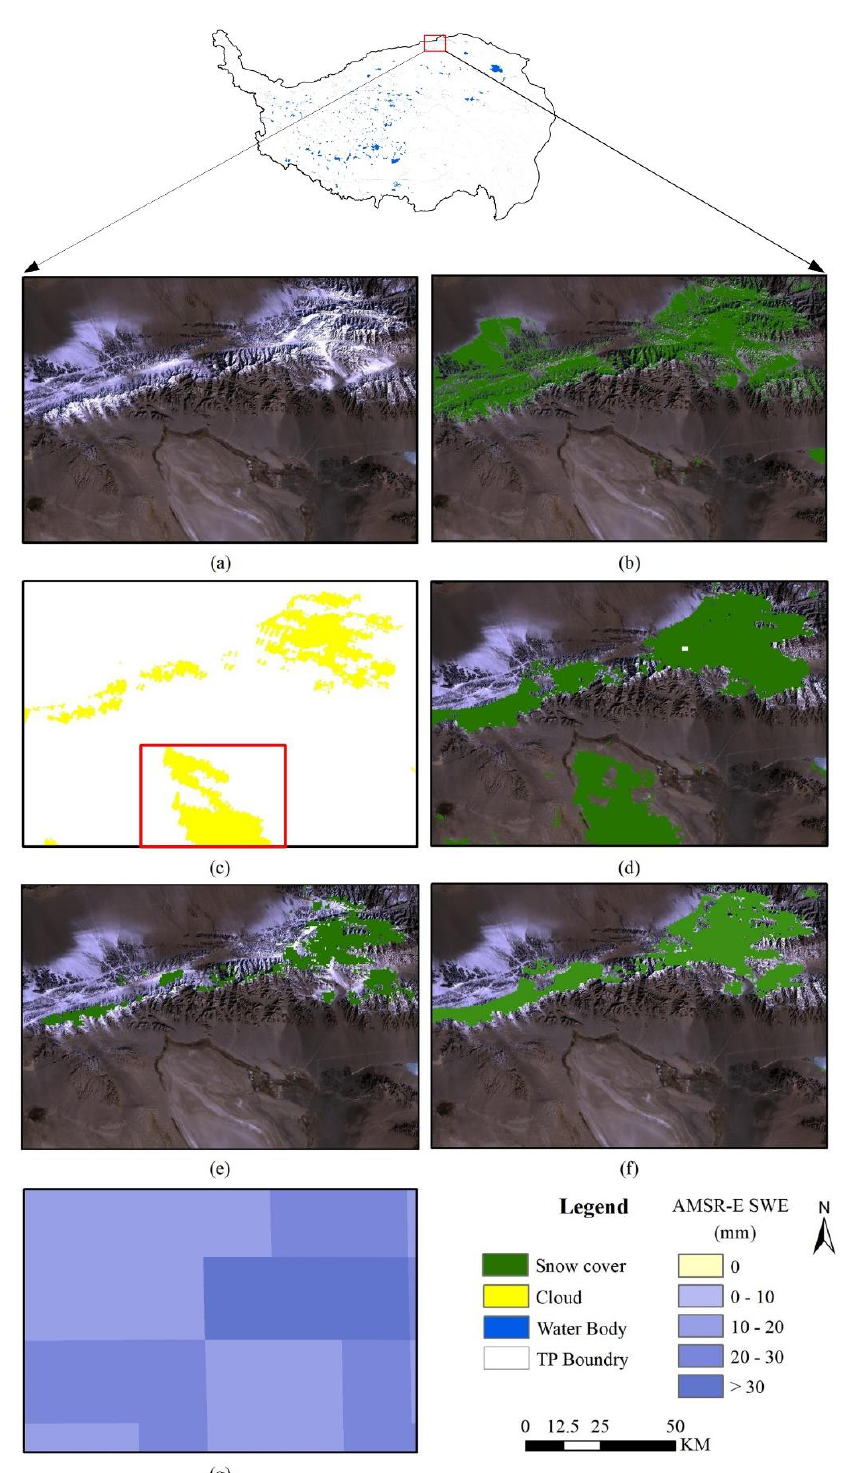
Figure 8. Partial enlarged picture in the south of the Qaidam Basin on 6 February 2004. ( a ) Landsat TM true color image (image ID: LT05_L1TP_138033_20040206_20161203_01_T1), ( b ) Landsat TM snow cover distribution (green), ( c ) The cloud distribution (yellow) retrieved from MOYD, ( d ) The snow cover distribution (green) retrieved from SC2, ( e ) The snow cover distribution (green) retrieved from SC3, ( f ) The snow cover distribution (green) retrieved from SC1, ( g ) The AMSR-E SWE. SC1, SC2, and SC3 were the snow cover products of the combined MOD10A1F and MYD10A1F (SC1) developed by Huang et al. [28] and Qiu et al. [29],